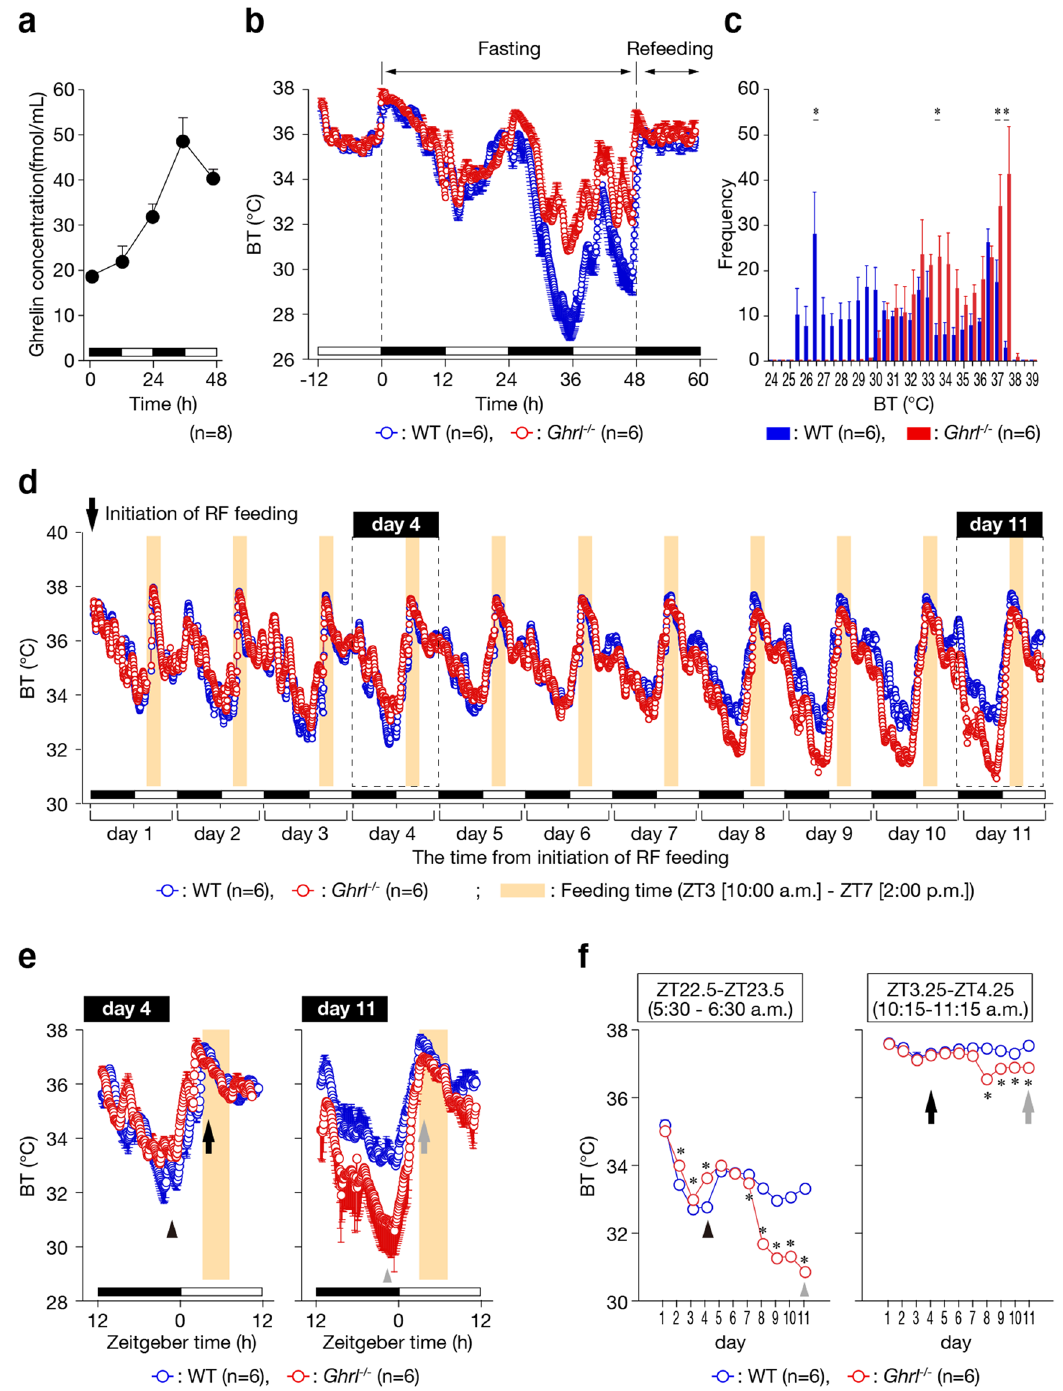
Figure 1. Lack of torpor induction in Ghrl −/− mice. ( a ) Plasma acyl ghrelin concentrations in fasting mice. Plasma was collected every 12 h. * P < 0.05 (0 h [n = 8] vs. 12, 24, 36, and 48 h [n = 8 for each group]). ( b ) Relatively high BT was observed in Ghrl −/− mice (n = 6) at times when torpor was induced in WT (n = 6). BT was measured every 5 min, and all data were averaged. ( c ) Frequency distribution of BT during the fast. Data were collected between 24 and 48 h after fasting initiation. * P < 0.05 (WT mice [n = 6] vs. Ghrl −/− mice [n = 6]). Error bars in all figures indicate S.E. ( d ) Characteristic BT changes in Ghrl −/− mice during restricted feeding. Mice were given food for 4 h from ZT3 (10:00 a.m.) to ZT7 (2:00 p.m.) per day. ( e ) Representative data during restricted feeding. Due to ghrelin deficiency, core BT was high during the fasting period on day 4, but low during the fasting period on day 11. ( f ) BT variations in the hunger and satiety periods. Left panel (a hunger period): ZT22.5 (5:30 a.m.)–ZT23.5 (6:30 a.m.); this hour represents the time that is the most hypothermic state. Right panel (a satiety period): ZT3.25 (10:15 a.m.)–ZT4.25 (11:15 a.m.); this hour is the time that reflects the BT of an early phase during the feeding period. * P < 0.05 (WT mice [n = 6] vs. Ghrl −/− mice [n = 6]). Error bars in ( e ) and ( f ) indicate